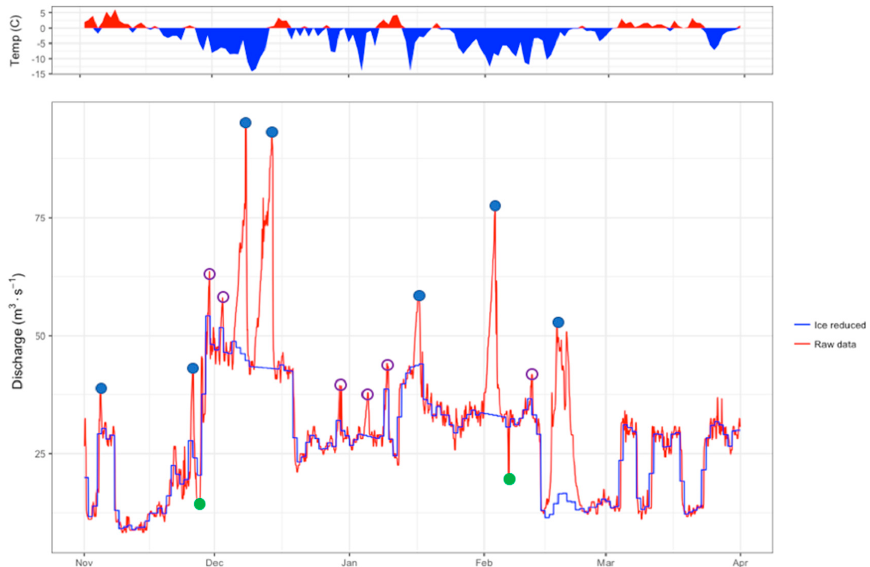
Figure 2. Air temperature (top panel) and identified peaks for one year at Syrstad (lower panel). Open circles are peaks that are considered natural, closed blue circles high peaks due to ice, and closed green circles are low peaks. Note that the variability of flow is driven by hydropower releases.